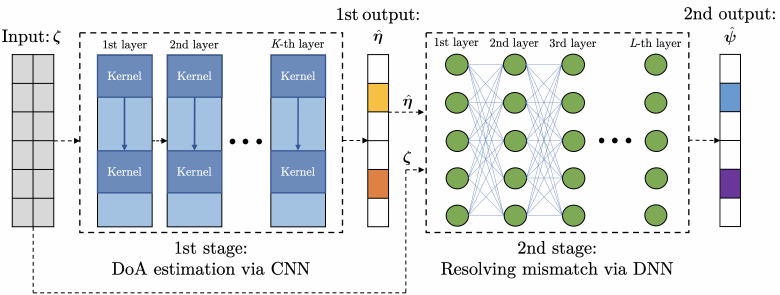
Figure 1. The structure of the two-stage cascaded NN. 1D convolutional layers construct the first- stage network, and dense layers construct the second-stage